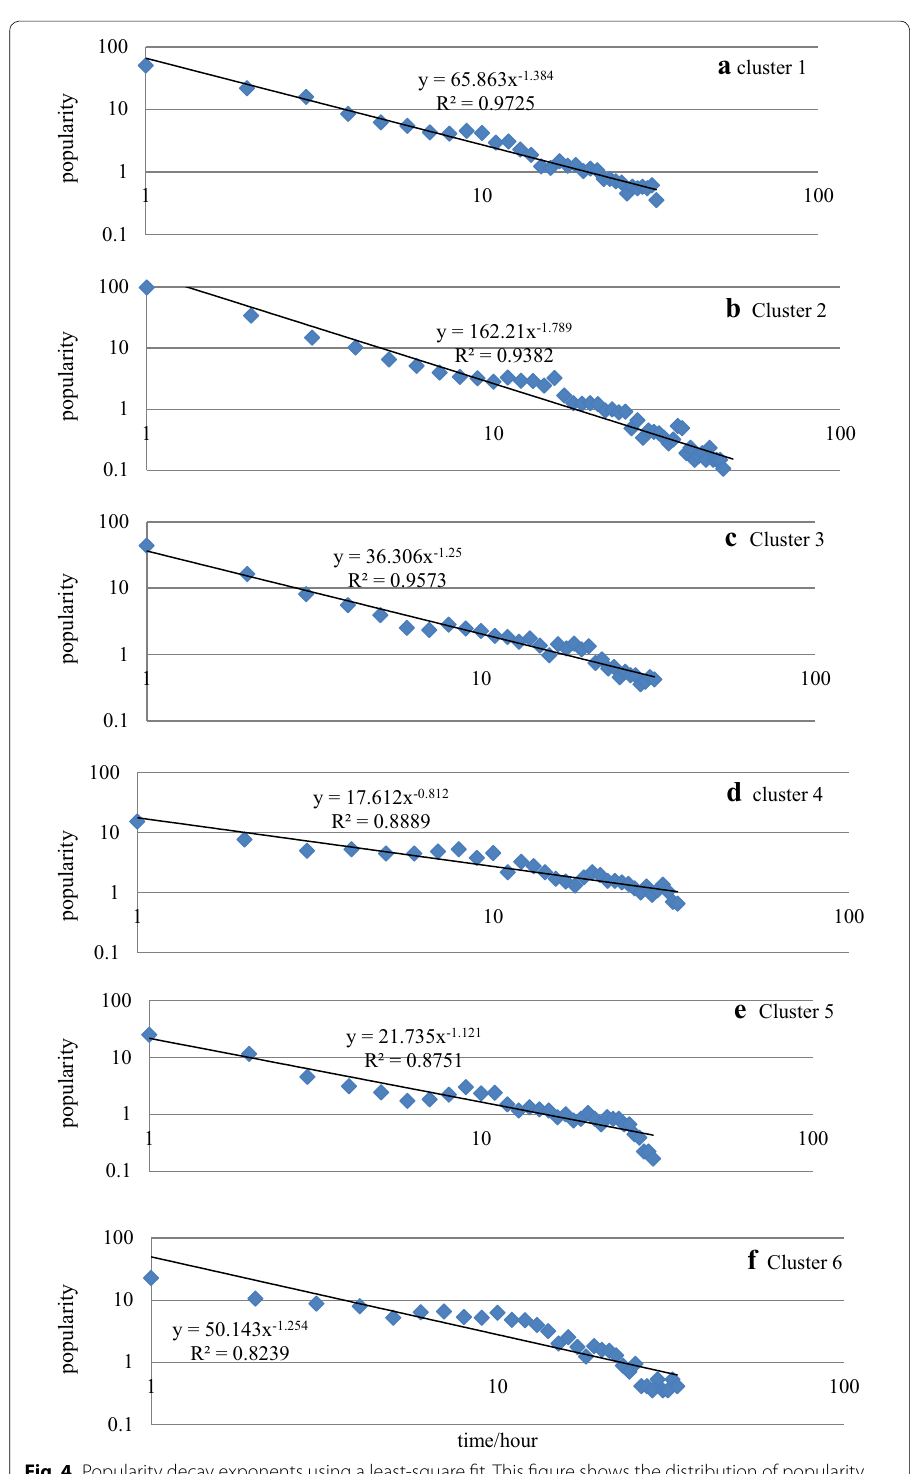
Fig. 4 Popularity decay exponents using a least-square fit. This figure shows the distribution of popularity decay after